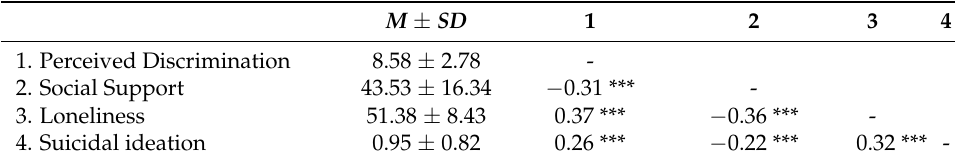
Table 2. Bivariate correlations and descriptive statistics among study